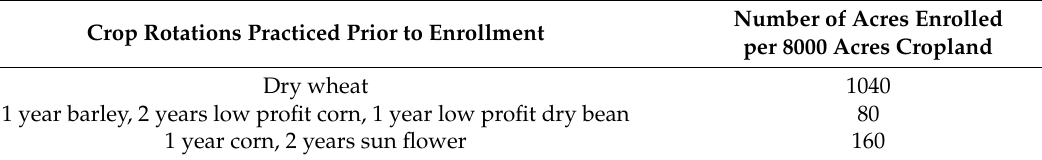
Table 4. Projected crop rotations and number of acres taken out of production. Crop Rotations Practiced Prior to